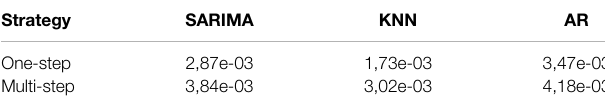
TABLE 1 | Average MSE for all periods. TABLE 2 | Comparison of average MSE in the two strategies considered: one- step- vs.